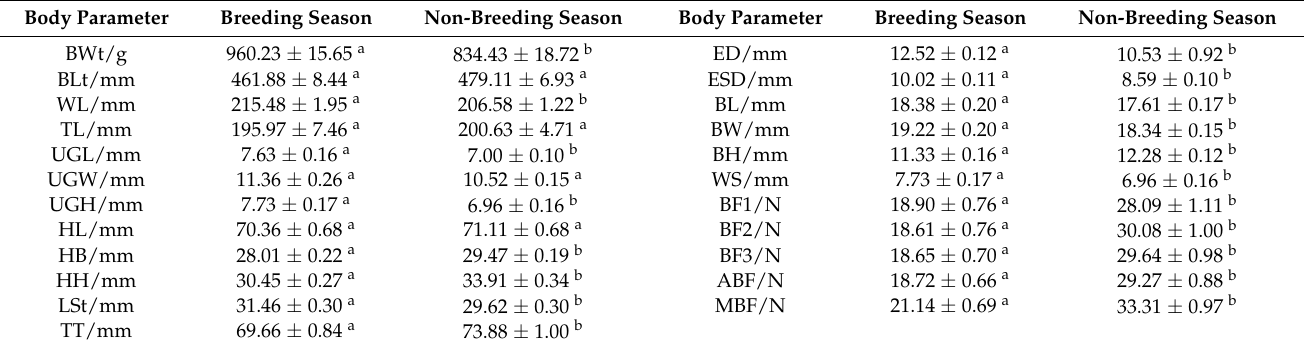
Table 3. Means ( ± SE) of body parameters of chickens in the breeding and non-breeding Table 3. Means (±SE) of body parameters of chickens in the breeding and non-breeding seasons.